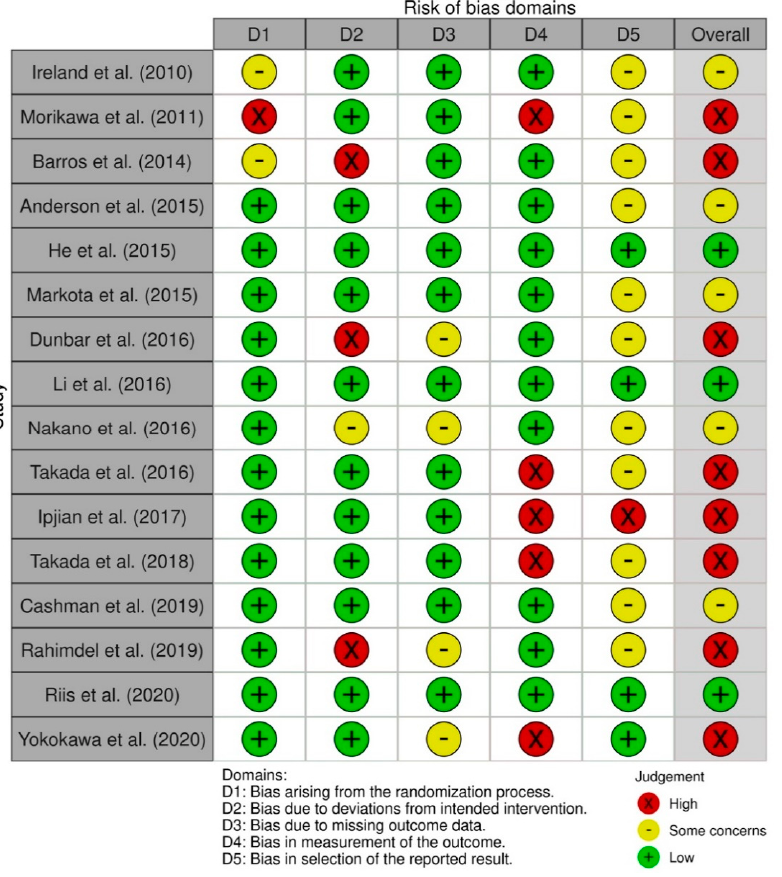
Figure 3 . Risk of bias summary for nonrandomized studies (ROBINS-I tool).